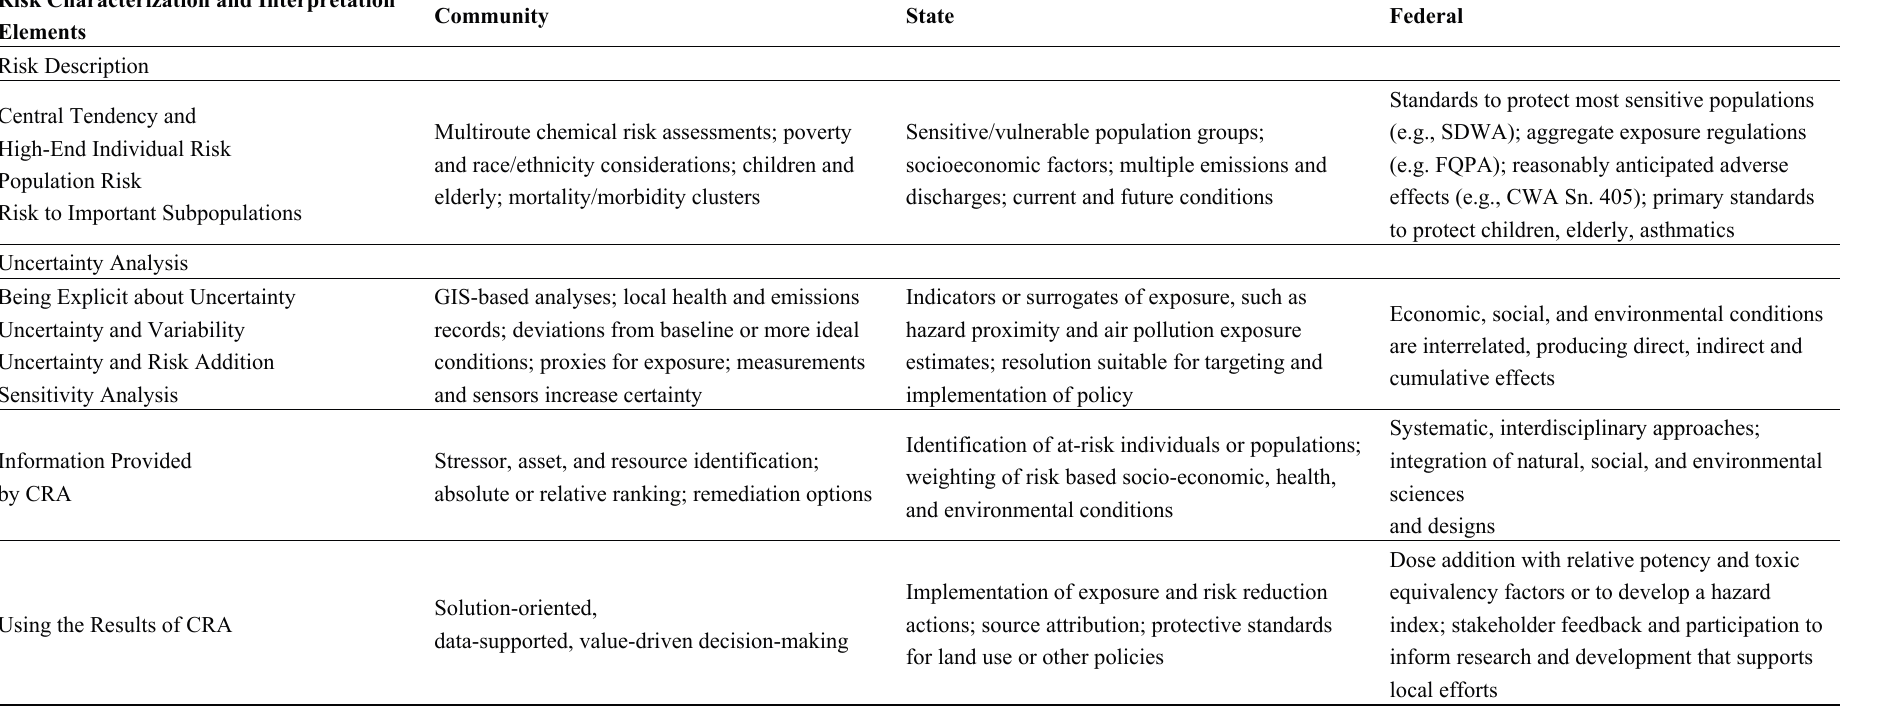
Table 4. Synopsis of Risk Characterization and Interpretation elements for Phase 3 of a CRA for Community, State, and Federal